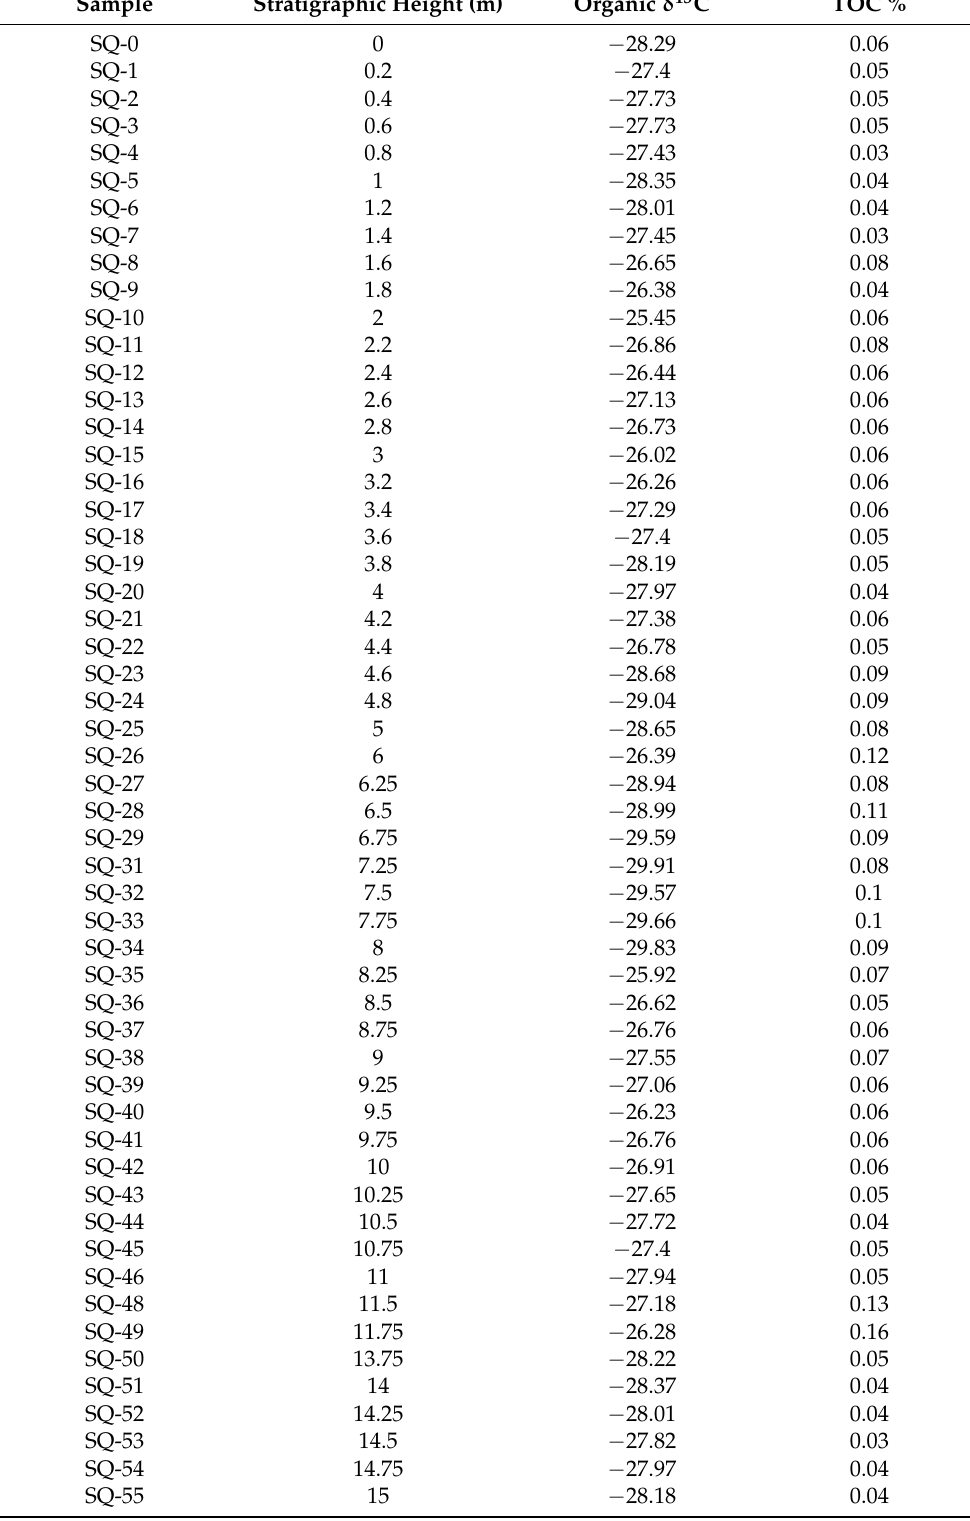
Table 1. Organic d13C and total organic carbon (TOC%) values from sedimentary rock samples at Utahraptor Ridge. Stratigraphic height refers to position in Figure